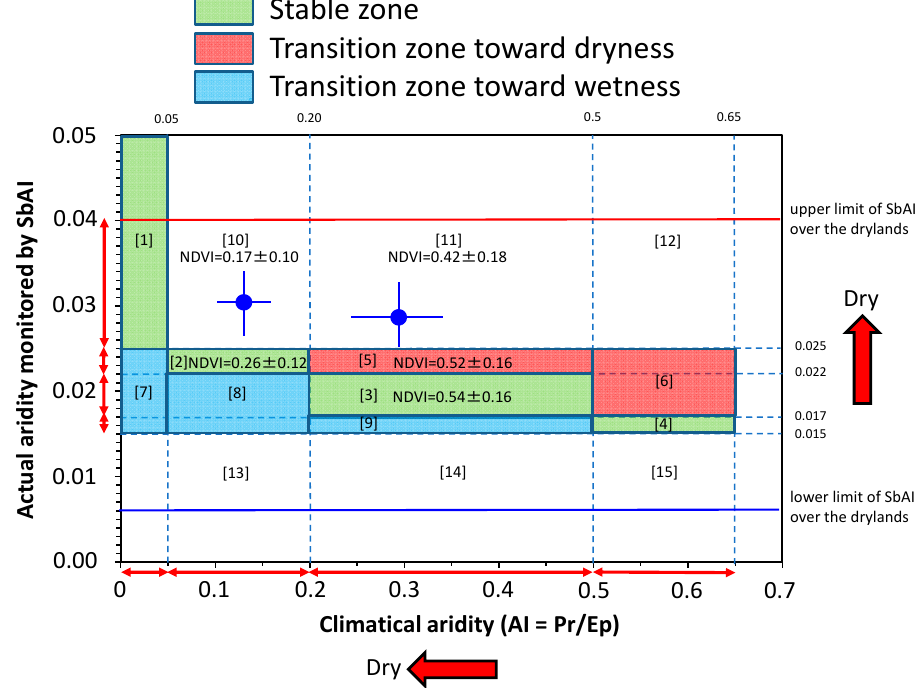
Figure 3. Relationship between the AI and SbAI, averaged over 2001–2013, and the 15 arid region categories. The red, double-headed arrows along the axes indicate the range of values of the indices that indicate hyper-arid, arid, semi-arid, and dry sub-humid regions. The blue dots with standard deviations indicate the actual ranges of the AIs and SbAIs in Mongolia (modified from [30]).